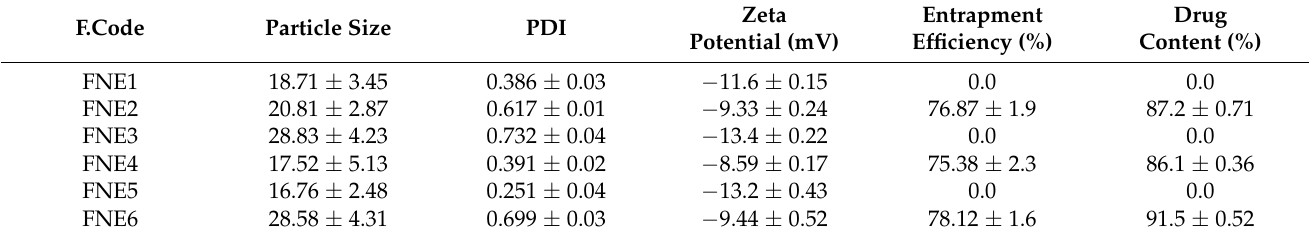
Table 3. Physicochemical characteristics of methotrexate